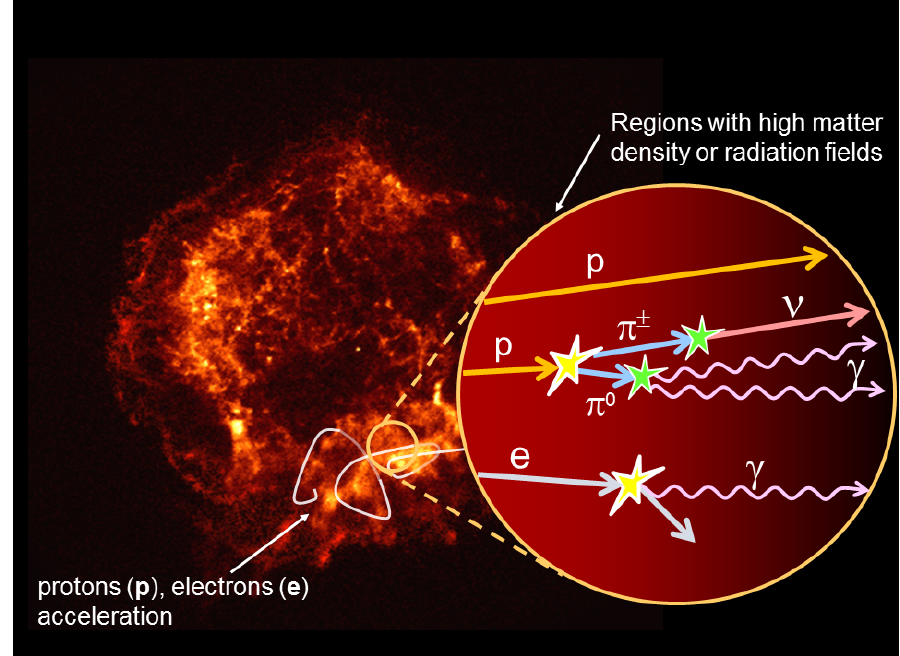
Figure 1. Astrophysical sources can accelerate CRs (protons, electrons and nuclei). A fraction of these particles diffuses outside the acceleration region, propagates in the galactic space (or intergalactic, if the source is external to the Galaxy) and can reach the Earth. Electrically charged cosmic rays do not travel in a straight line due to magnetic field deflections. Another fraction of accelerated protons (or nuclei) can instead interact with matter ( pp -mechanism) or radiation fields ( p γ -mechanism) surrounding the source. In this case, the decay of a neutral secondary particle (mainly π 0 ) produces a γγ -pair, while the decay of charged particles (mainly π ± ) produces (anti)neutrinos. The interaction of electrons with matter or radiation produces only γ -rays. Thus, the detection of neutrinos from the direction of a source is a unique way to find out what are the accelerators of protons and